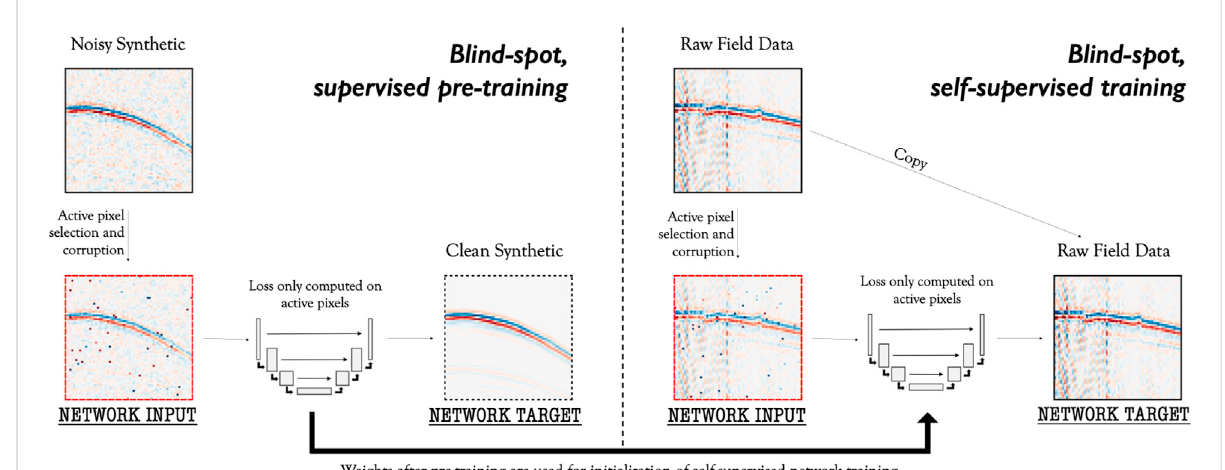
FIGURE 3 Proposedwork fl owfortheincorporationoftransferlearningintoself-supervised,blind-spotnetworks.First,ablind-spotnetworkistrainedina supervised fashion with a clean target (left). The weights after training are then used to initialise a new network, which is trained directly on the fi eld data, in a self-supervised